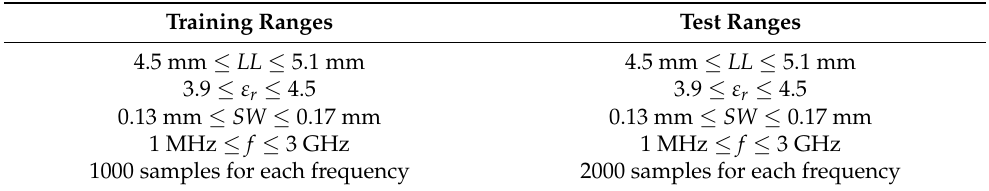
Figure 1. ( a ) Design parameters of the serpentine line to be analyzed; ( b ) cross-sectional view of the serpentine line. Table 1. Serpentine delay line parameters for the training and test